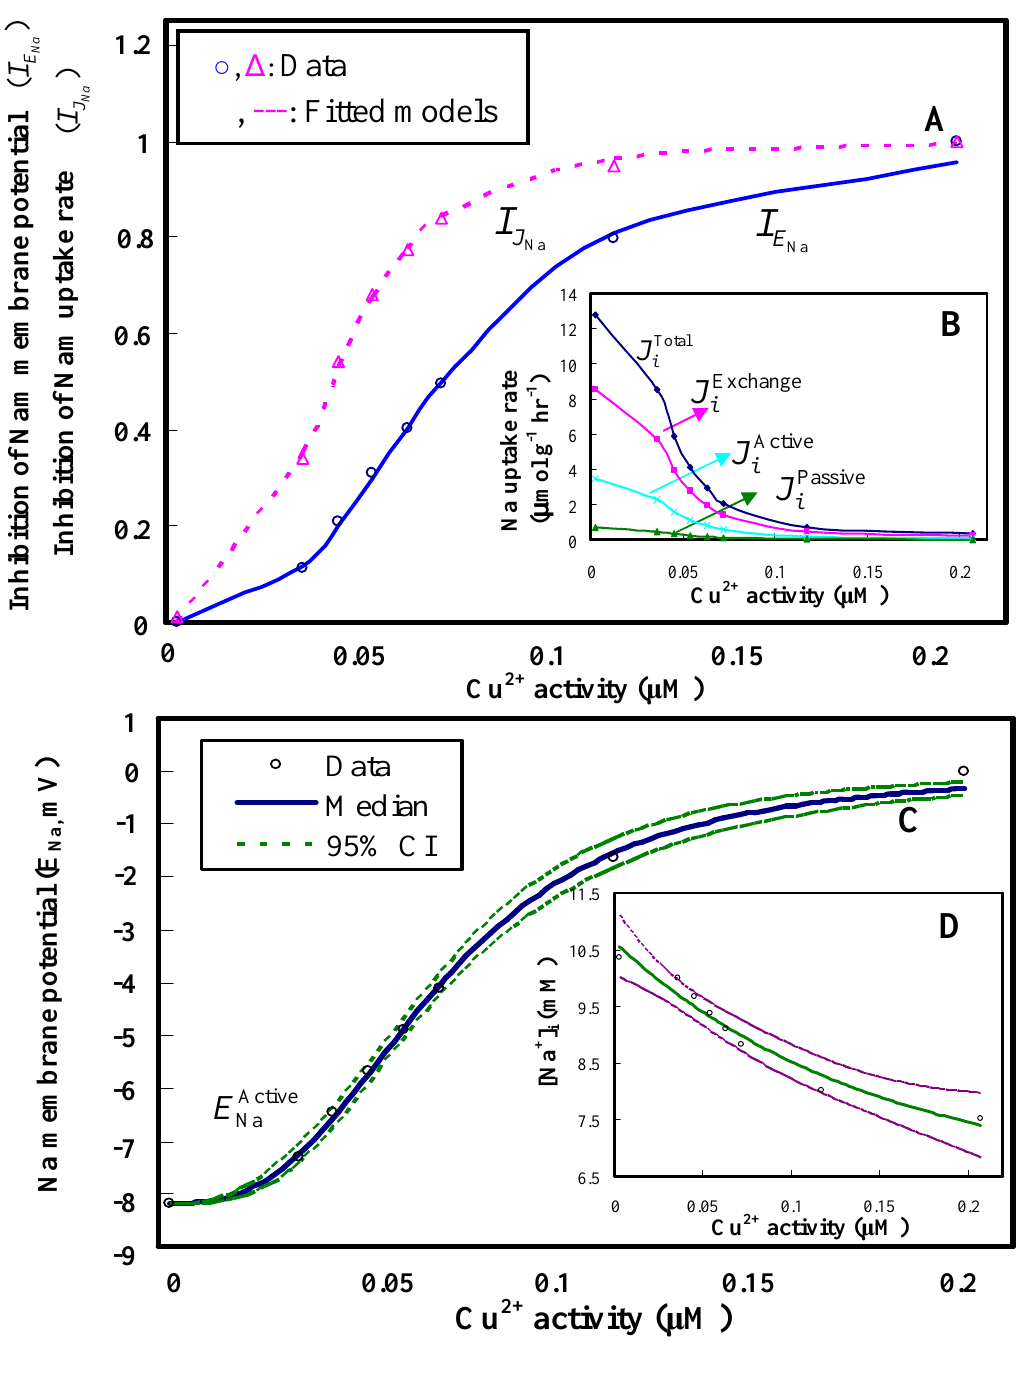
Figure 5. Predicted dose-response profiles. (A) Hill-based dose-response profiles showing the relationships between inhibitions of Na membrane potential/Na uptake rate and Cu 2+ activity. (B) Cu 2+ activity-dependent Na uptake rate profiles partitioning with different transport mechanisms of exchange, passive, active, and total influxes. (C) Prediction of active gill potentials at a non-equilibrium condition, showing increasing of Cu 2+ activities has a mild depolarization process from - 8.2 to mV. Predicted Cu 2+ activity-dependent internal Na concentration in blood showing the changes of internal Na concentration from 10.56 to 7.40 mM varied with Cu + activities ranging from 0 - 0.21 m